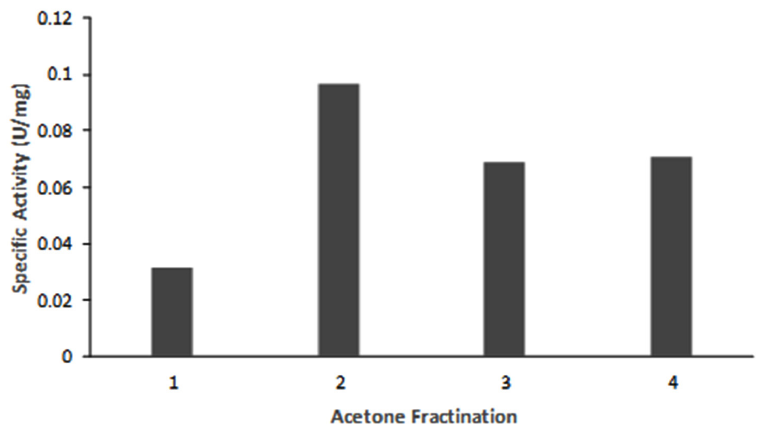
Fig. 1. Activity of the partial purified enzyme. One unit of lipase is defined as the amount of enzyme producing 1 mmol PNP per minutes under the assay conditions. (1) crude of extract enzyme, (2) Fraction 0-20%, (3) Fraction 20-40%, (4) Fraction 40-60